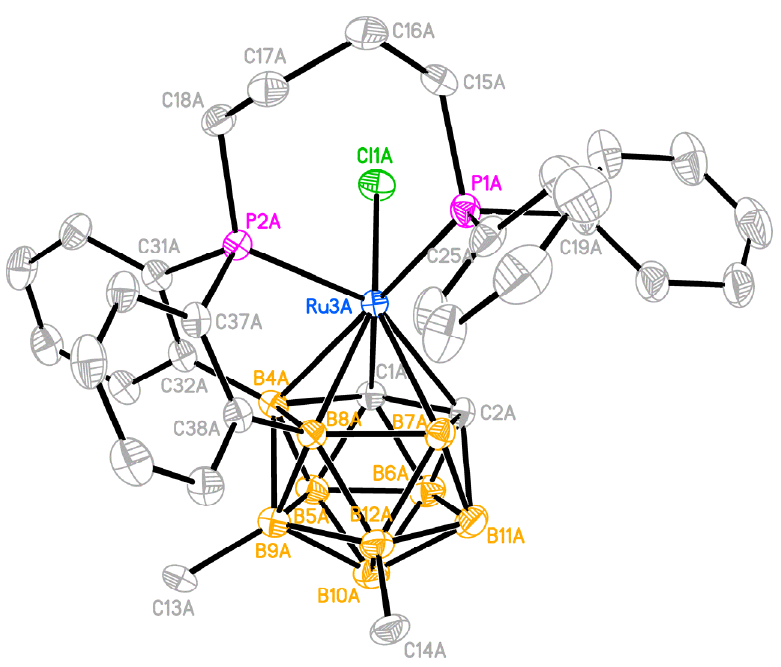
Figure 5. Molecular structure one of two symmetrically independent molecules of ruthenacarborane 9 (thermal ellipsoids drawn at the 50% probability level). Hydrogen atoms have been omitted for clarity. Table 1. Selected bond lengths (Å) and angles (deg.) in the discussed ruthenacarboranes. Parameter